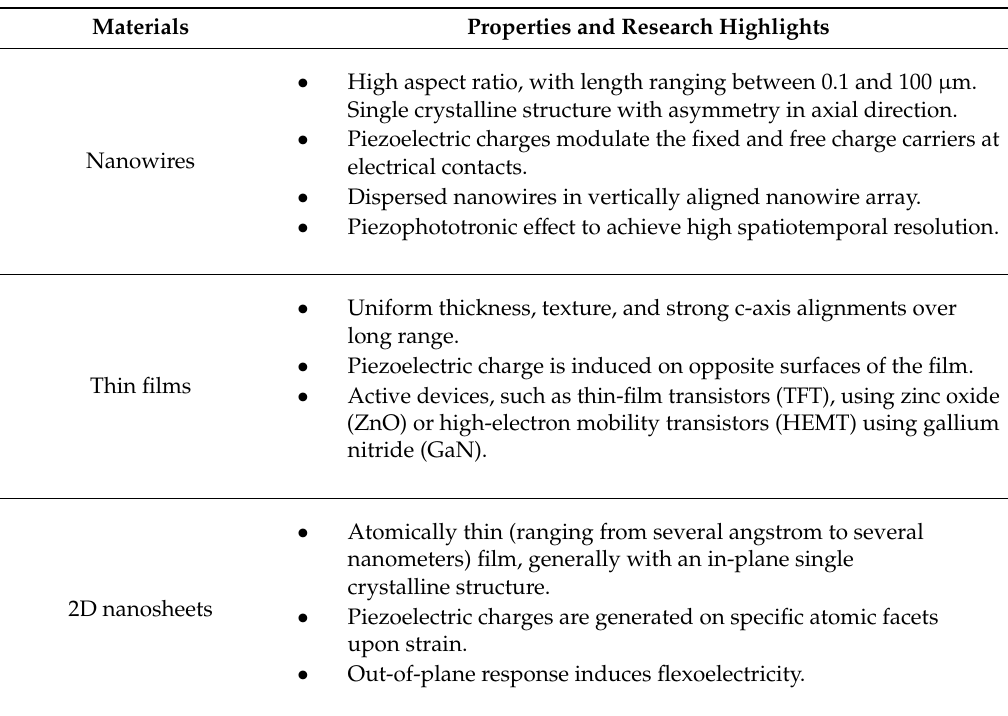
Table 1. Material dimensions of active piezoelectric